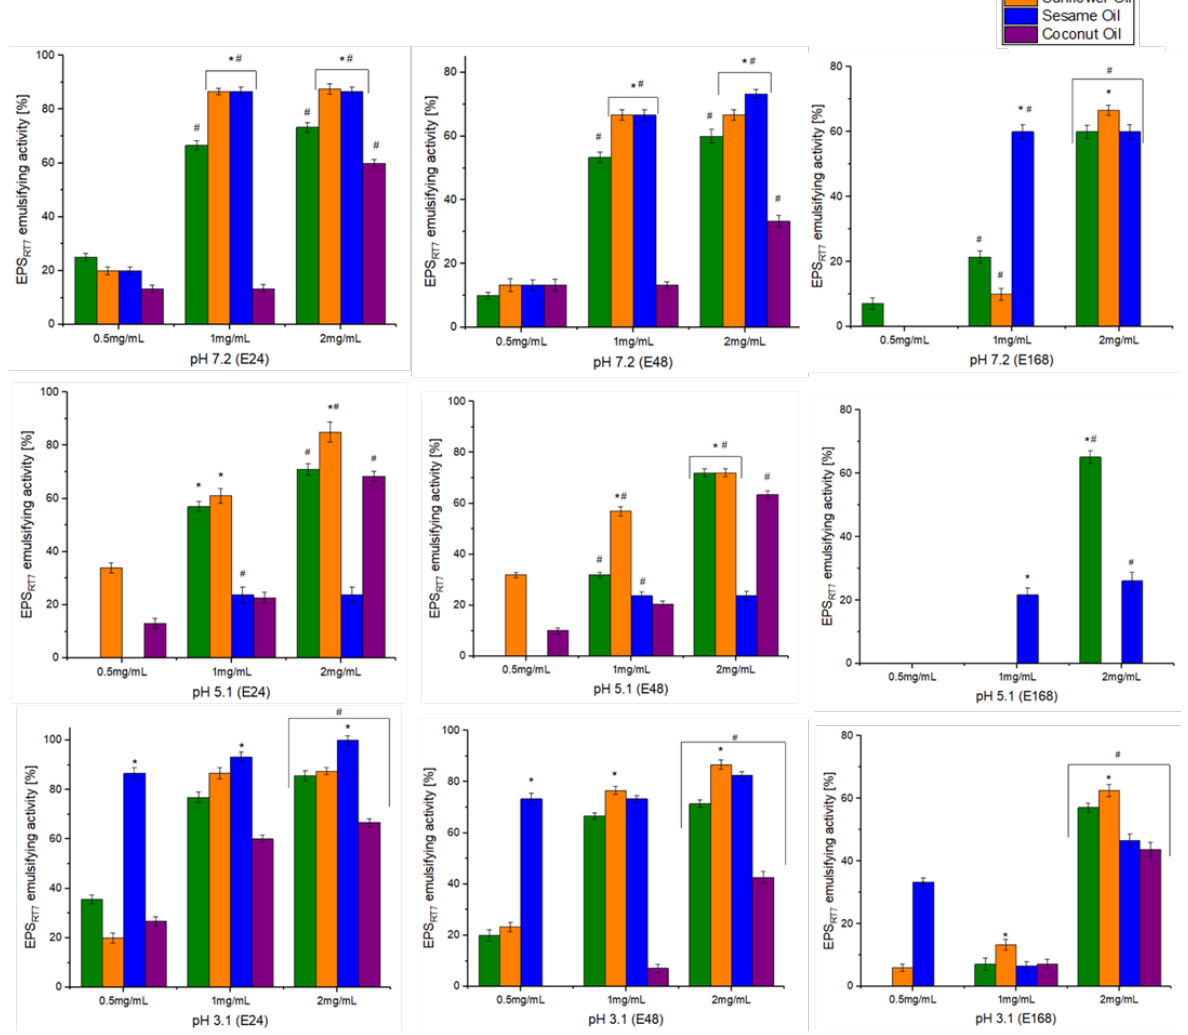
Figure 4. Emulsifying activity for natural oils with different EPS RT7 concentrations (0.5, 1, 2 mg/mL) and pH levels (7.2, 5.1, 3.1). Emulsion percentages of EPS RT7 with different oils used at 24, 48, and 168 h of study are also shown. *, statistical differences between oils for each concentration ( p < 0.05). #, statistical differences between concentrations ( p < 0.05).